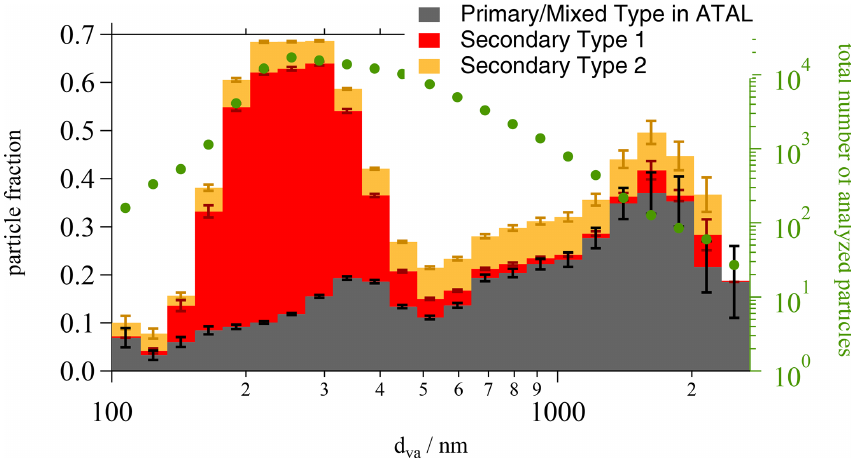
Figure 10. Size-resolved fraction of the identified particle types as measured by the ERICA-LAMS. The figure represents the cumulative particle fraction of the identified particle types: Secondary Type 1 (red) and Secondary Type 2 (orange), as well as the total number of analyzed particles per bin (dark green). The distribution of Primary/Mixed Type particles (dark gray) is limited to particles in the ATAL; thus the fractions do not add up to 1. Uncertainty analysis is provided in Sect. S2.2. This graph does not show the complete size distribution of the ambient aerosol, the lower cutoff in particular is strongly influenced by the ability to detect small particles with ERICA.